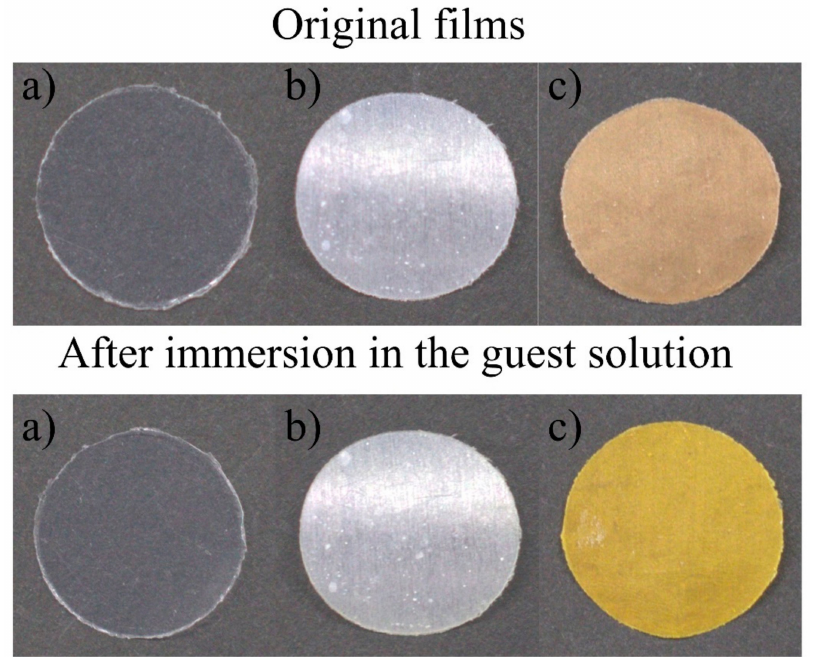
Figure 7. Photographs of the ( a ) original ETFE film, ( b ) the ETFE- g -PSt-CHO, and ( c ) the ETFE- g -PAP-15-C-5-Ar before ( top ) and after ( bottom ) immersion in the azo-NH 3 Cl aqueous